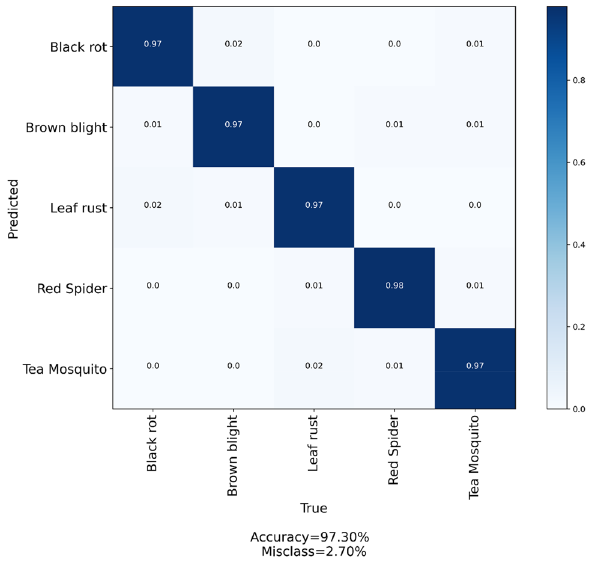
Figure 9. Confusion matrix diagram for the proposed YOLO-T model.